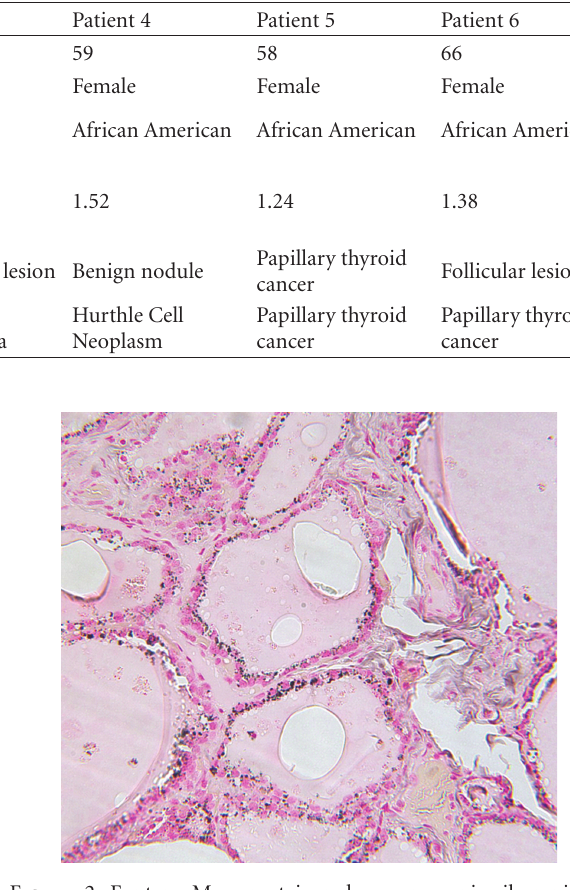
Figure 2: Fontana-Masson stain reduces ammonia-silver nitrate and turns black (positive) in black